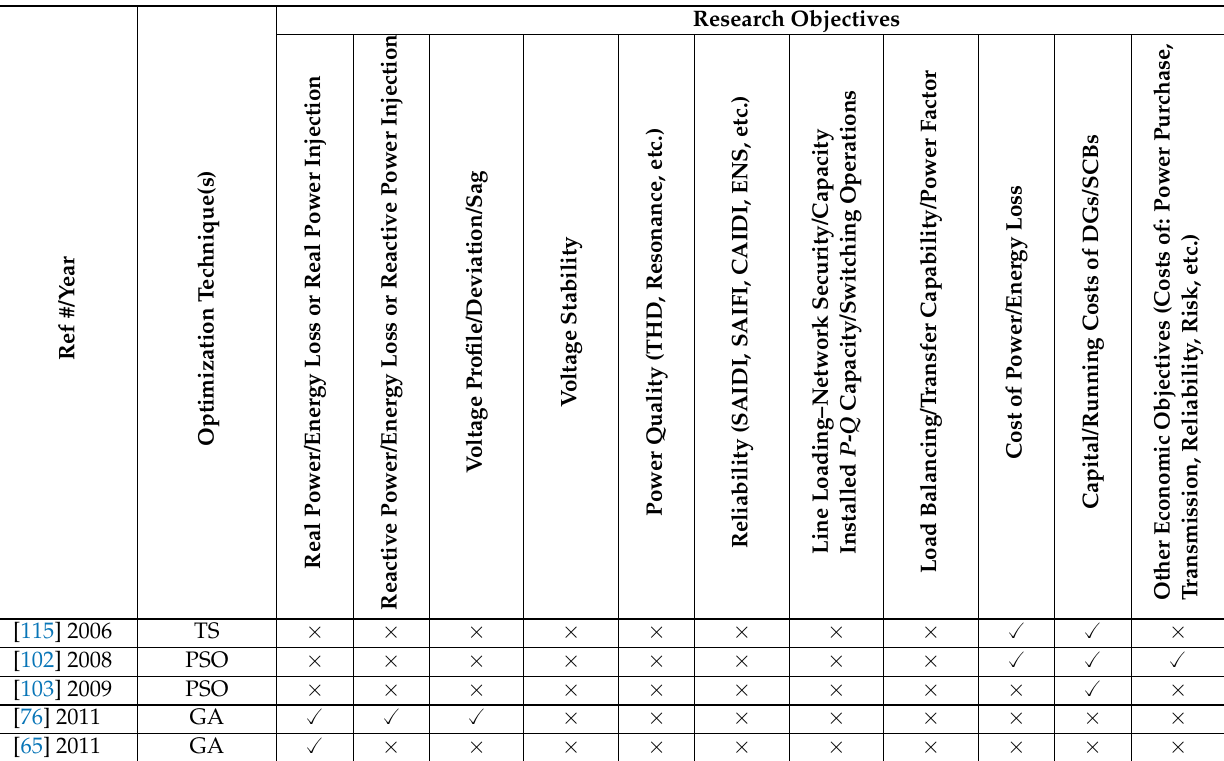
Table 2. Research objectives and optimization techniques presented in the existing studies for the simultaneous allocations of DGs and